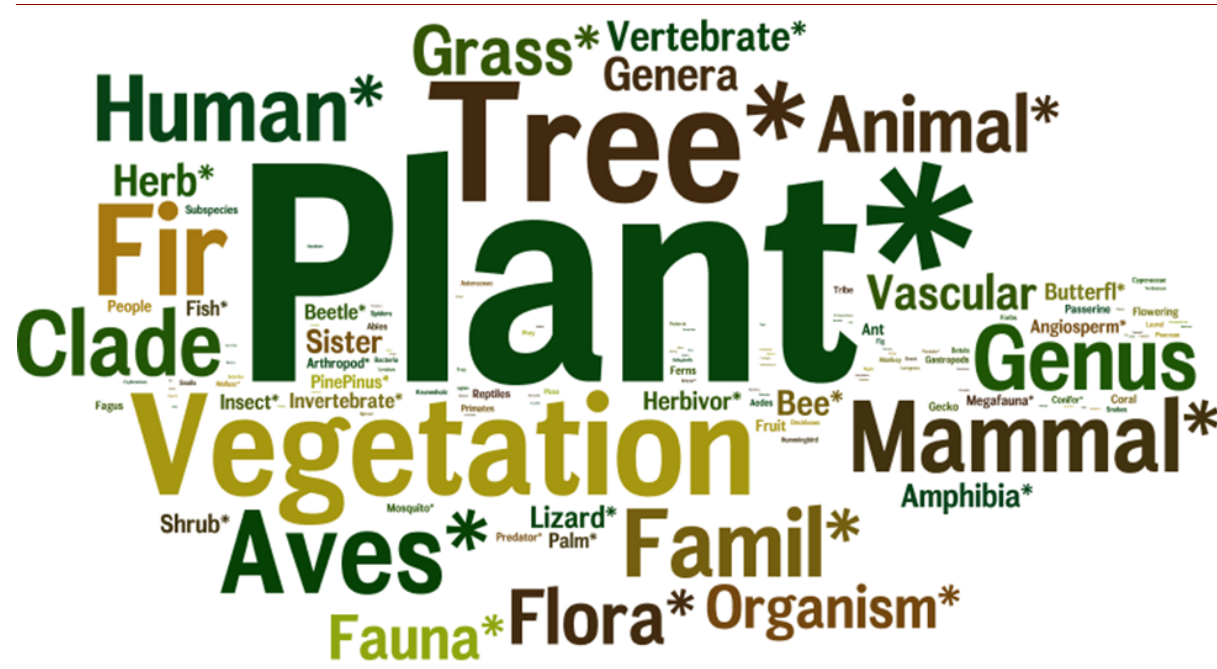
Figure 3. Terms related to taxa that appeared commonly in abstracts submitted for the 7 th IBS biennial meeting. Analysis as described in the caption to Figure 1; based on n = 1189. Asterisks indicate the word also occurred in plu- w ral or other form (e.g., “Aves*” represents also the use of “Bird” and “Birds”; Flora includes “Floras” and “Floristic”). The most common term (“Plant*”) in the analysis occurred in 131 abstracts; the least common term in the analysis occurred once. As noted in Figure 1, the word “Species” was excluded from this analysis but was present in 451 of the 521